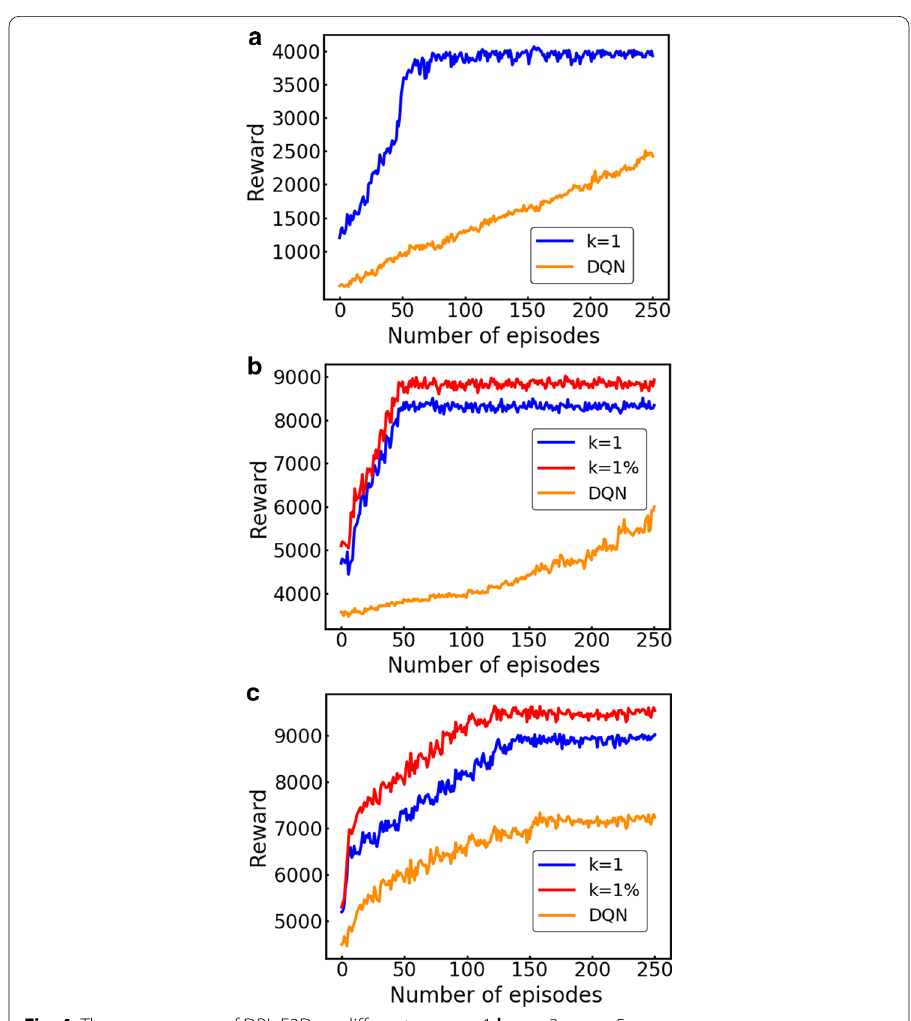
Fig. 4 The convergence of DRL-E2D on different n . a n = 1 . b n = 3 . c n =